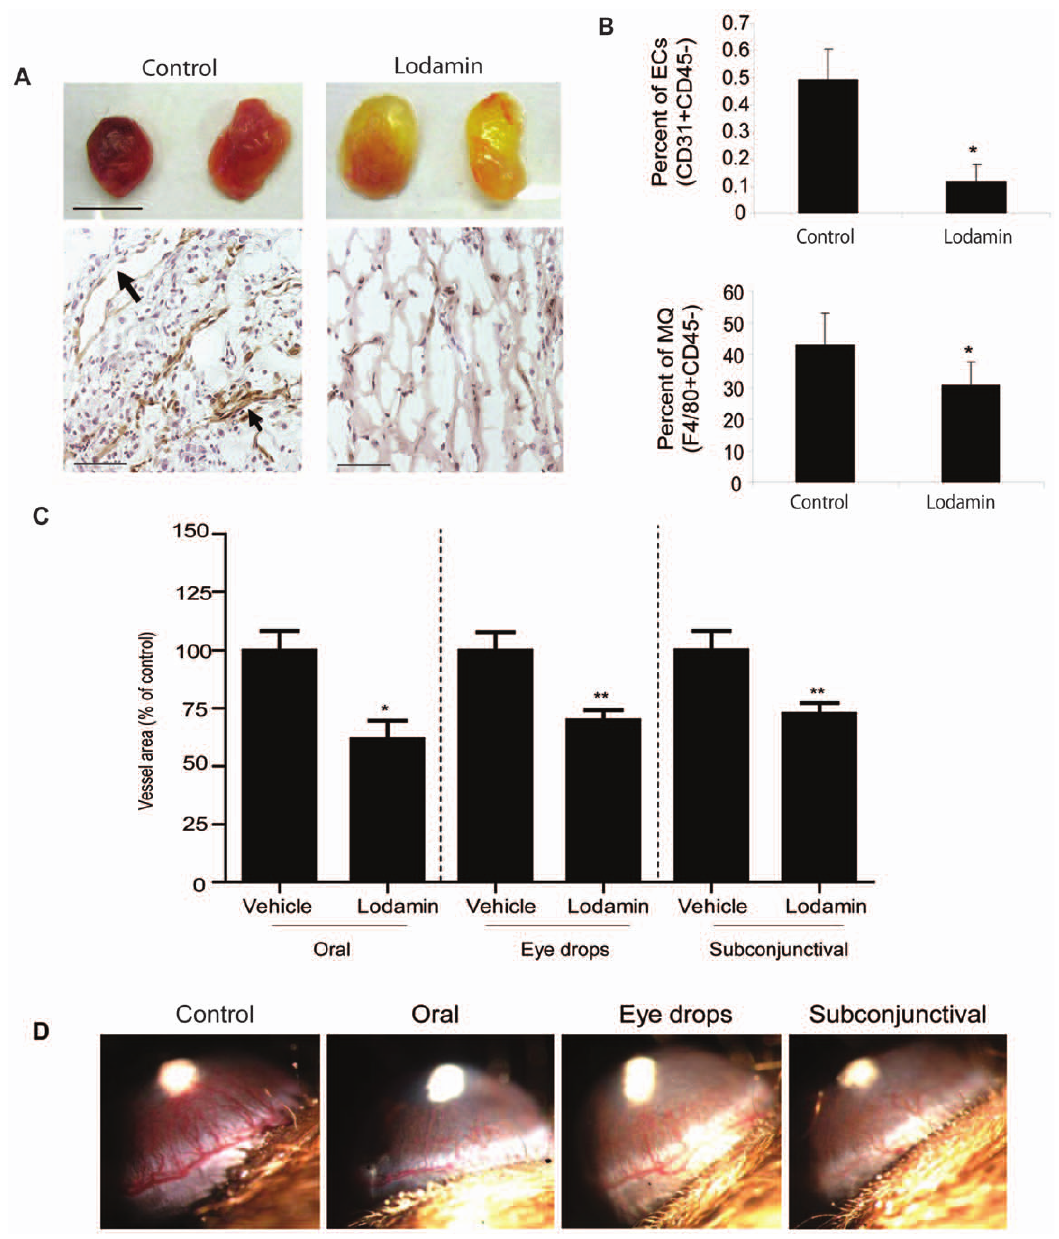
Figure 1. Lodamin inhibits angiogenesis and inflammation in Matrigel plugs and inhibits corneal neovascularization after local or oral treatment. ( A ) Matrigel containing VEGF and bFGF was injected subcutaneously (s.c., n=5) to determine the effect of Lodamin on angiogenesis and macrophage infiltration. Upper panel shows representative plugs removed from Lodamin treated or untreated mice (bar=1 cm). Bottom panel shows vessel staining with anti-CD31 antibody (brown) and nuclei staining with Hematoxilin Gill’s (blue), bar=100 m m; arrows point to large vessel with open lumans ( B ) Quantification of infiltrating endothelial cell or macrophages in Matrigel plugs. Data are presented as percent of specific cell population out of the total cell population (n=3–4, p , 0.05). ( C ) Antiangiogenic activity of Lodamin following topical or systemic administration was evaluated in the mouse corneal micropocket assay using bFGF-induced neovascularization. Quantification of vessel area (mm 2 ) in different corneal assays performed with Lodamin which were administered either orally (30 mg/kg q.d), by eye drops (30 mg/ml, q.d) or by subconjunctival injections (30 mg/ml, q.d). Graphs indicate the significant inhibition of vessel formation after 5 days of treatment. Vessel area was reduced by 38% after subconjunctival injection ( P =0.0002), by 30% after eye drops treatment ( P =0.003), and by 37% ( P =0.04) after oral administration. In each group n=10. ( D ) Representative images taken from the different groups at day 5; bFGF pellet is detected as a white spot in the center of the cornea, blood vessels growing from limbal periphery are reduced in Lodamin treated group compared to controls. Vessel area in mm 2 is calculated by the following formula: p 6 clock hours 6 vessel length (mm) 6 0.2 mm.